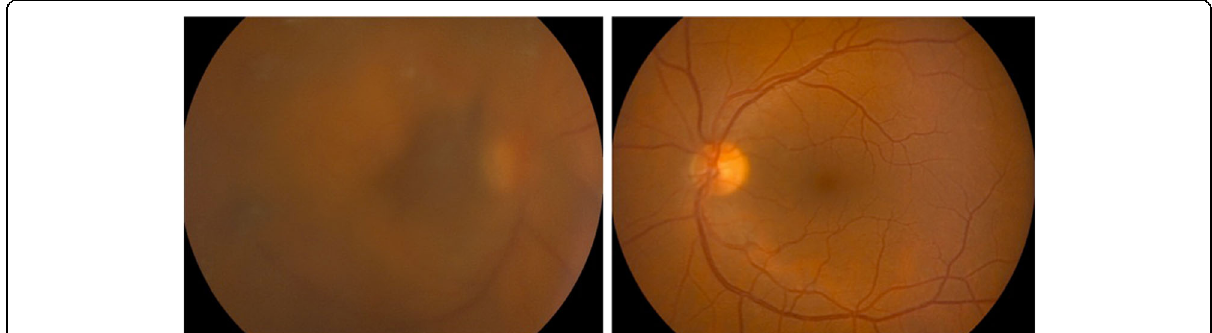
Fig. 3 Retinographies after diagnostic vitrectomy performed in the left